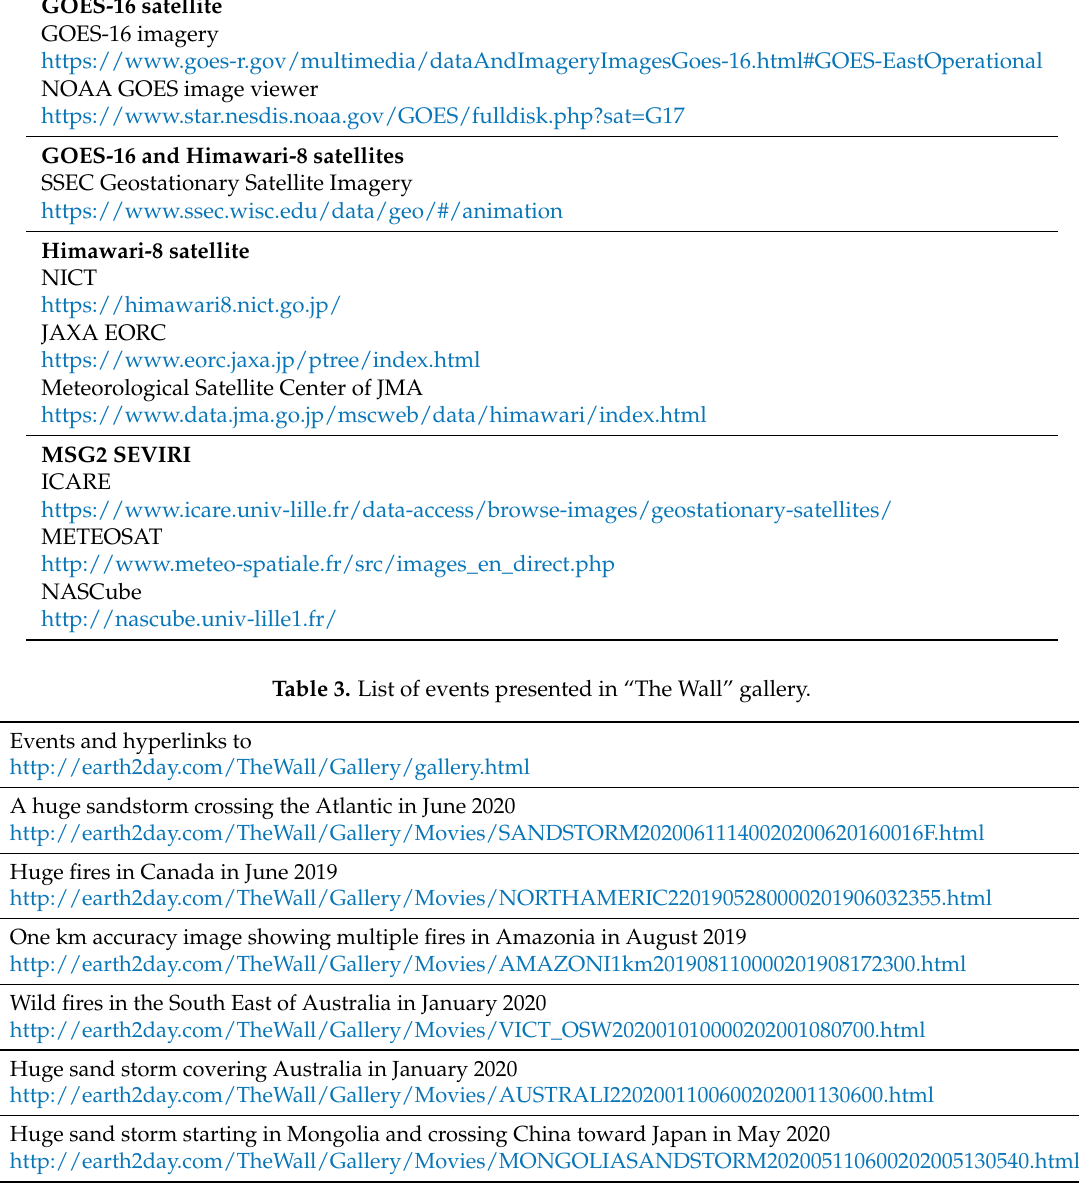
Table 2. An incomplete list of web-based platforms for geostationary satellite imagery.